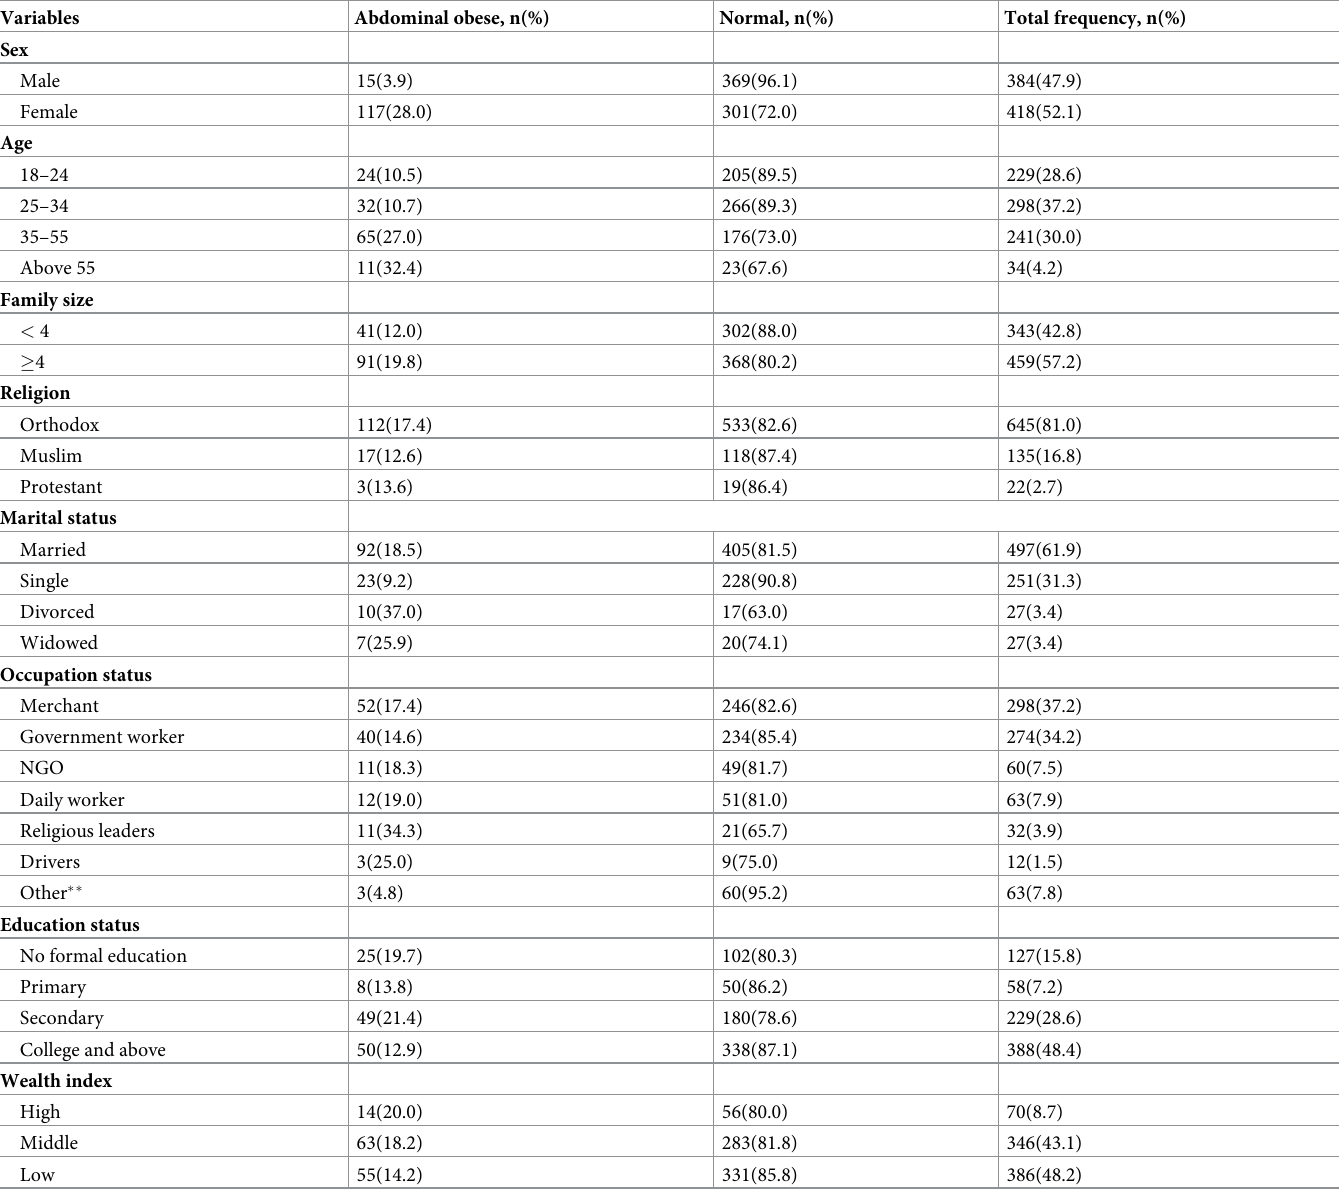
Table 1. Socio-demographic and economic characteristics of adult population in Woldia town, Northeast Ethiopia,